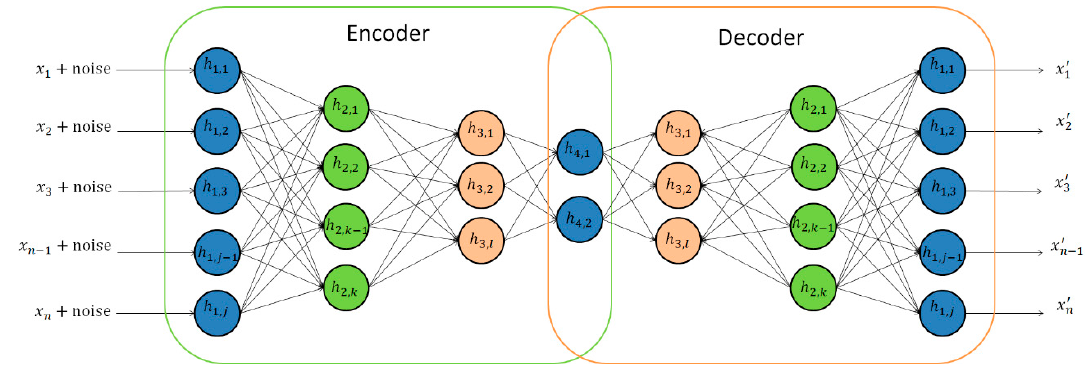
Figure 4. Denoising autoencoder.